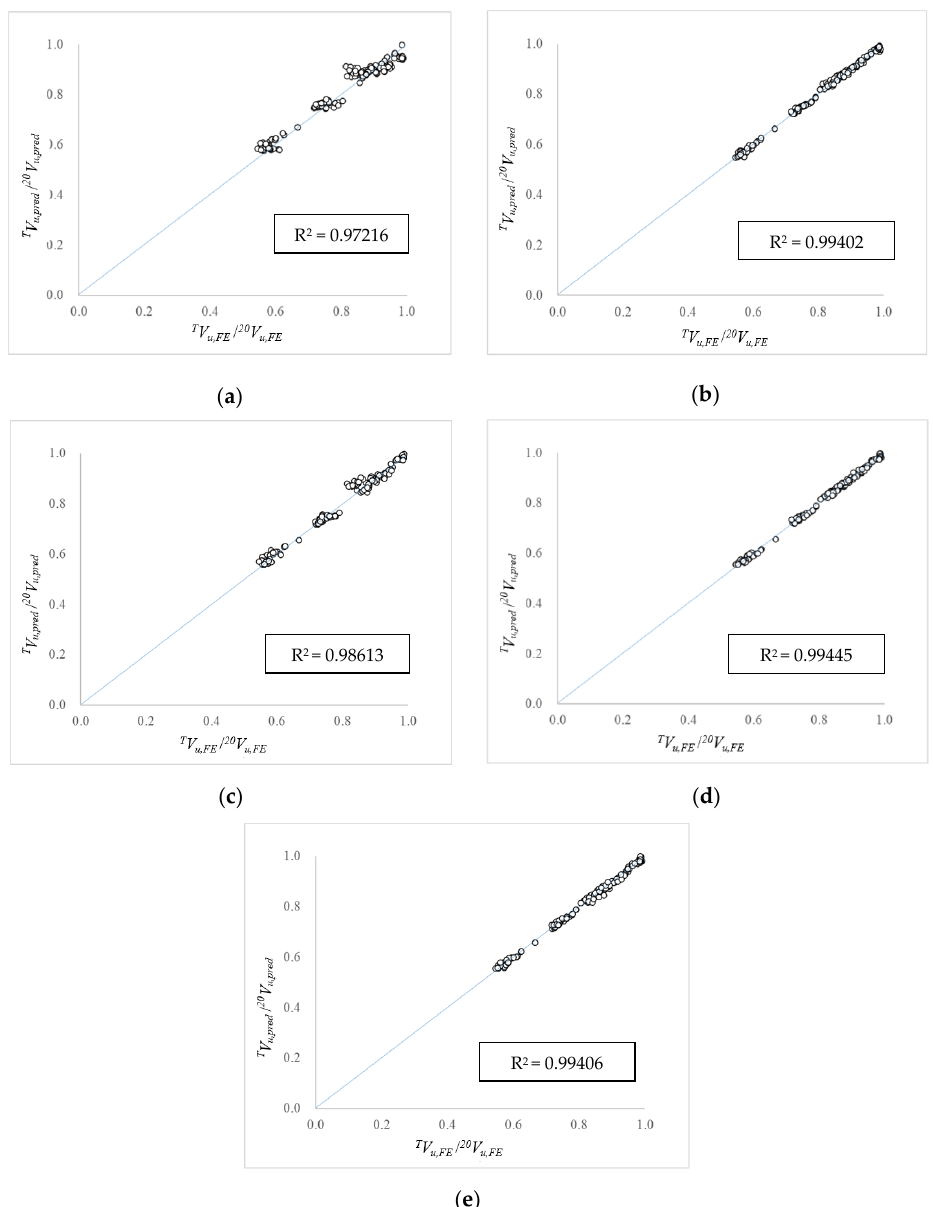
Figure 15. Training and test results of machine learning methodology for T V u / 20 V u ratio. ( a )